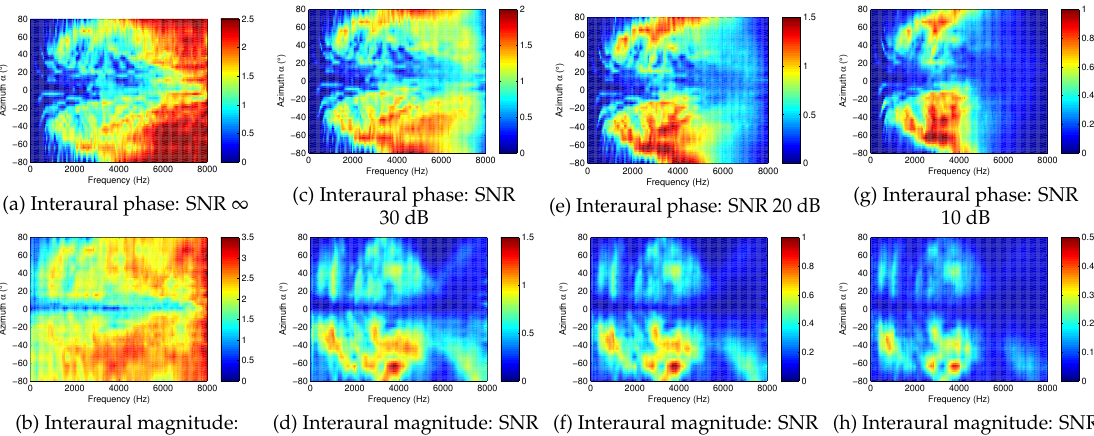
Figure 1. Mutual Information between the spatial cues and the elevation for a range of azimuths, frequencies and noise conditions.